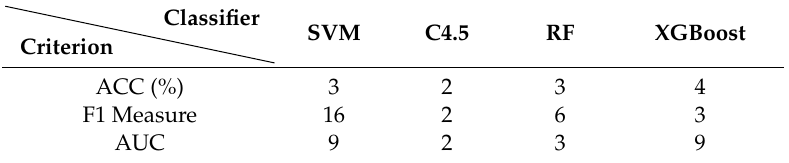
Table 5. The number of optimal feature subsets for each classifier under three criteria.